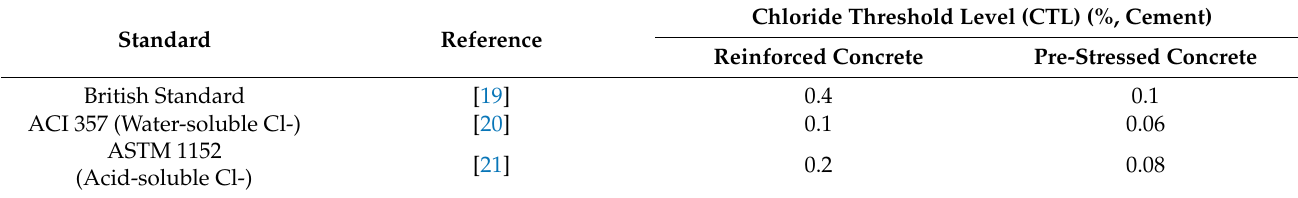
Table 1. Chloride threshold values specified by different